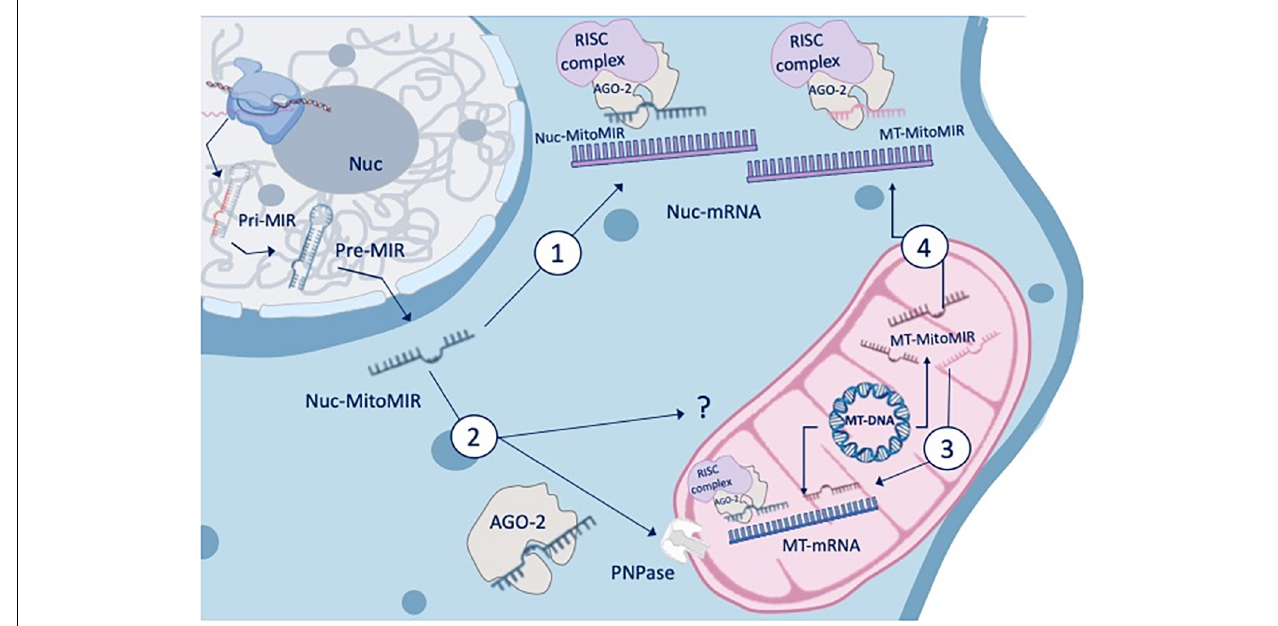
FIGURE 1 | MitomiR and gene regulation. The three main types of miRNAs that are enriched in the mitochondrial fractions can either originate from the nuclear genome and mature in the cytoplasm to target cellular genes that modulate mitochondrial functions (nuc-MiR) or translocate into the mitochondria to target mitochondrial genes and functions (nuc-MitomiR), or be transcribed from the mitochondrial genome and target mitochondrial genes and functions (MT-MitomiR). The AGO2 protein, an endonuclease, has been reported to colocalize with mitochondria, and to be associated with small mtRNA. RNA and MitomiR import into mitochondria is facilitated by multi-subunit RNA import complex (RIC), through a pathway independent of protein import and recently, through AGO2 and the protein PNPase (poly nucleotide phosphorylase).